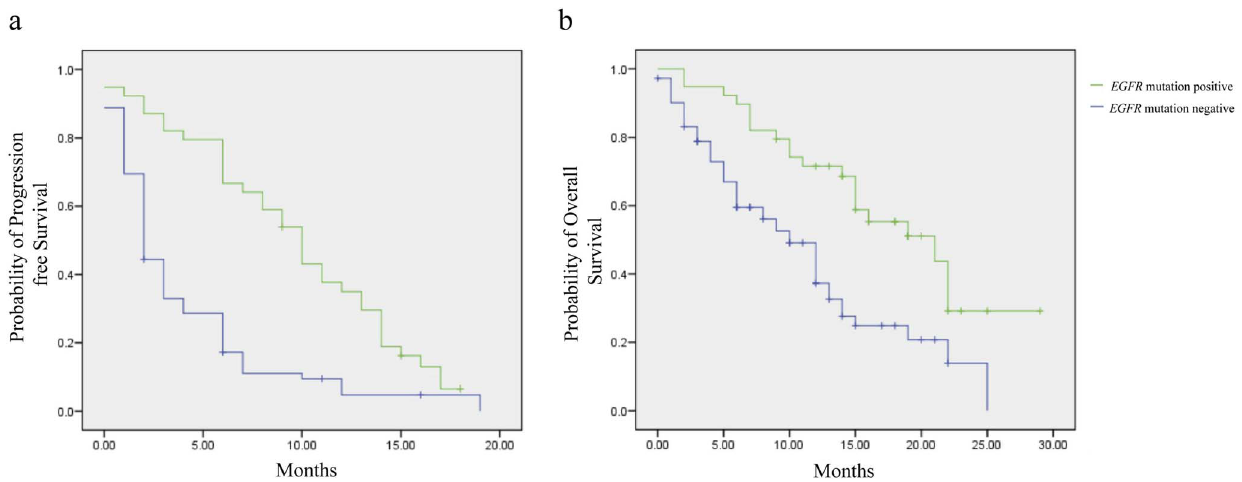
Figure 1. Survival by EGFR mutation status. (A) Progression-free survival (PFS) for the EGFR mutant patients was 10 months (95% CI: 8–11.9 months), while the estimated median PFS for EGFR mutation negative patients was 2 months (95% CI: 1.5–2.5 months), p=0.000 by log rank test (Mantel Cox). (B) Overall survival (OS) for EGFR mutant patients was 21 months (95% CI: 12.4–25.6 months), while the estimated median OS for EGFR mutantion negative patients was 10 months (95% CI: 7.4–12.6 months), p=0.001 by log rank test (Mantel Cox).